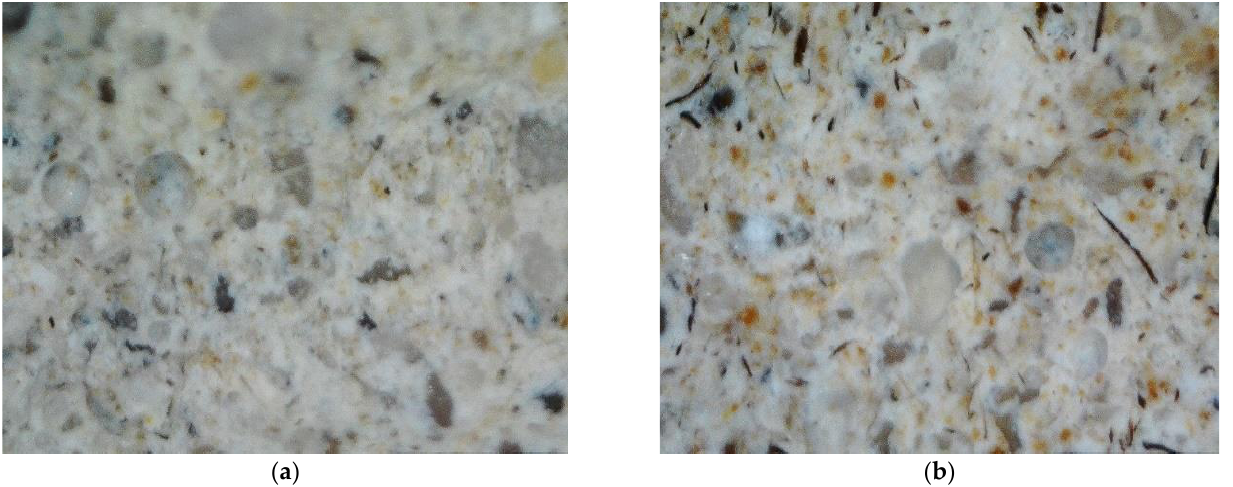
Figure 7. Sample C30 macrostructure zoomed in 12 times: ( a ) before fire effect; ( b ) after fire effect. Cement, MKA and milled quartz particle size determination research showed that used MKA average particle size is 15.34 μm, milled quartz sand is 17.66 μm, while cement is 21.71 μm.